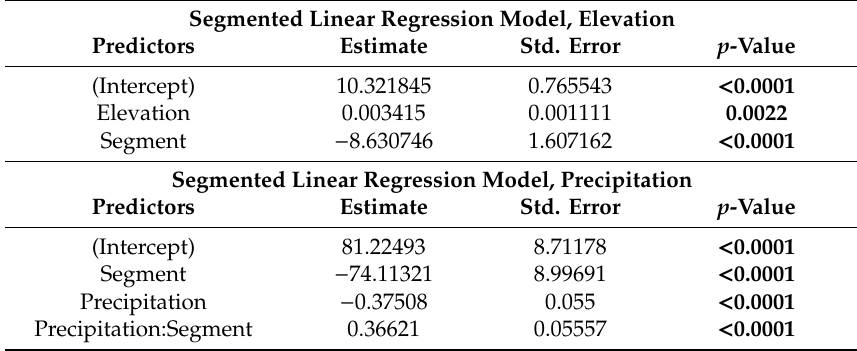
Table A5. Detailed model fits for the segmented multiple linear regressions of GFC tree cover against precipitation and segment, and elevation and segment, respectively. The best-fit model for elevation did not include an interaction with segment, while the best-fit model for precipitation included an interaction with segment.